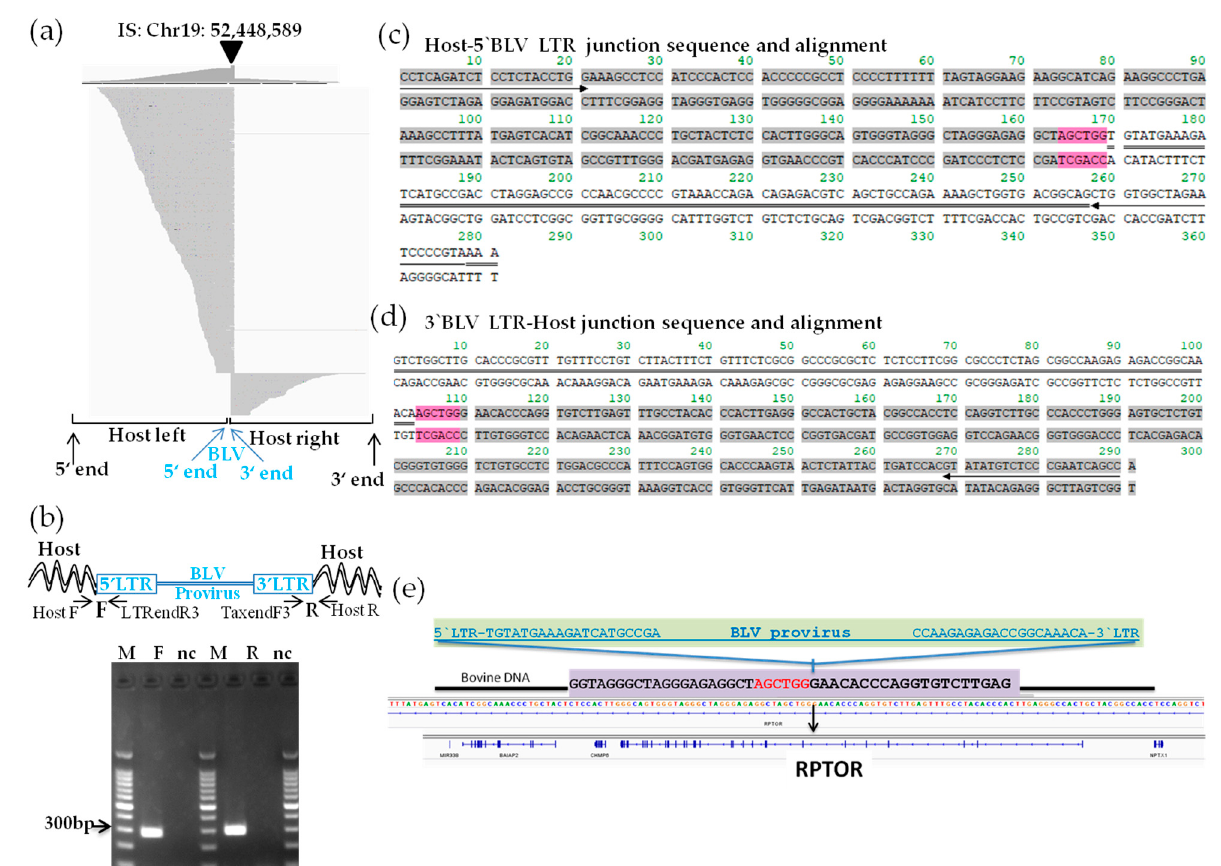
Figure 5. Visualization of next-generation sequencing (NGS) reads mapped to the bovine genome around the integration site of BLSC-KU1 and confirmation of its provirus integration sites. ( a ) Paired-end read mapping and visualization of host genome sequences in which the BLV provirus is integrated in BLSC-KU1. The arrow-head indicates the location of the integration site. The sequences of virus–host chimeric reads next to the end of the BLV genome are indicated as host-left and host-right, respectively. ( b ) Confirmation of detected integration sites by electrophoresis of PCR amplicons. Arrow indicates forward (F) and reverse (R) primer binding sites corresponding to cattle and BLV proviral sequences. M, molecular weight marker (100-bp DNA Ladder); nc, no-template DNA-negative control (water substituted for DNA template). ( c , d ) Sequence result of host–5 ′ -BLV LTR ( c ) and 3 ′ -BLV LTR–host ( d ) junction DNA in BLSC-KU1 cells. Sequences with gray color indicate host cattle genome; sequences with double line indicate the BLV provirus sequence; 6 bp nucleotide sequences colored in pink indicate duplicated host cattle sequences. Arrow indicates primer binding site. ( e ) Schematic presentation of BLV integration in the intron of regulatory-associated protein of mTOR (RPTOR) of chromosomal (Chr)19 nt 52,448,589 in KU1 cell lines.